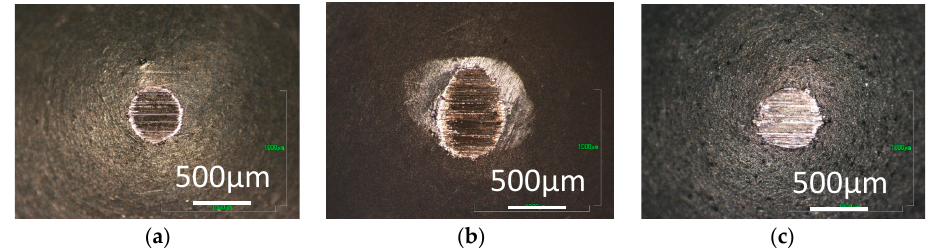
Figure 3. Photographs of aluminum pins slid against a-C:H DLC in hydrogen; with ( a ) 0 ppm water; ( b ) 60 ppm water; and ( c ) 160 ppm water.